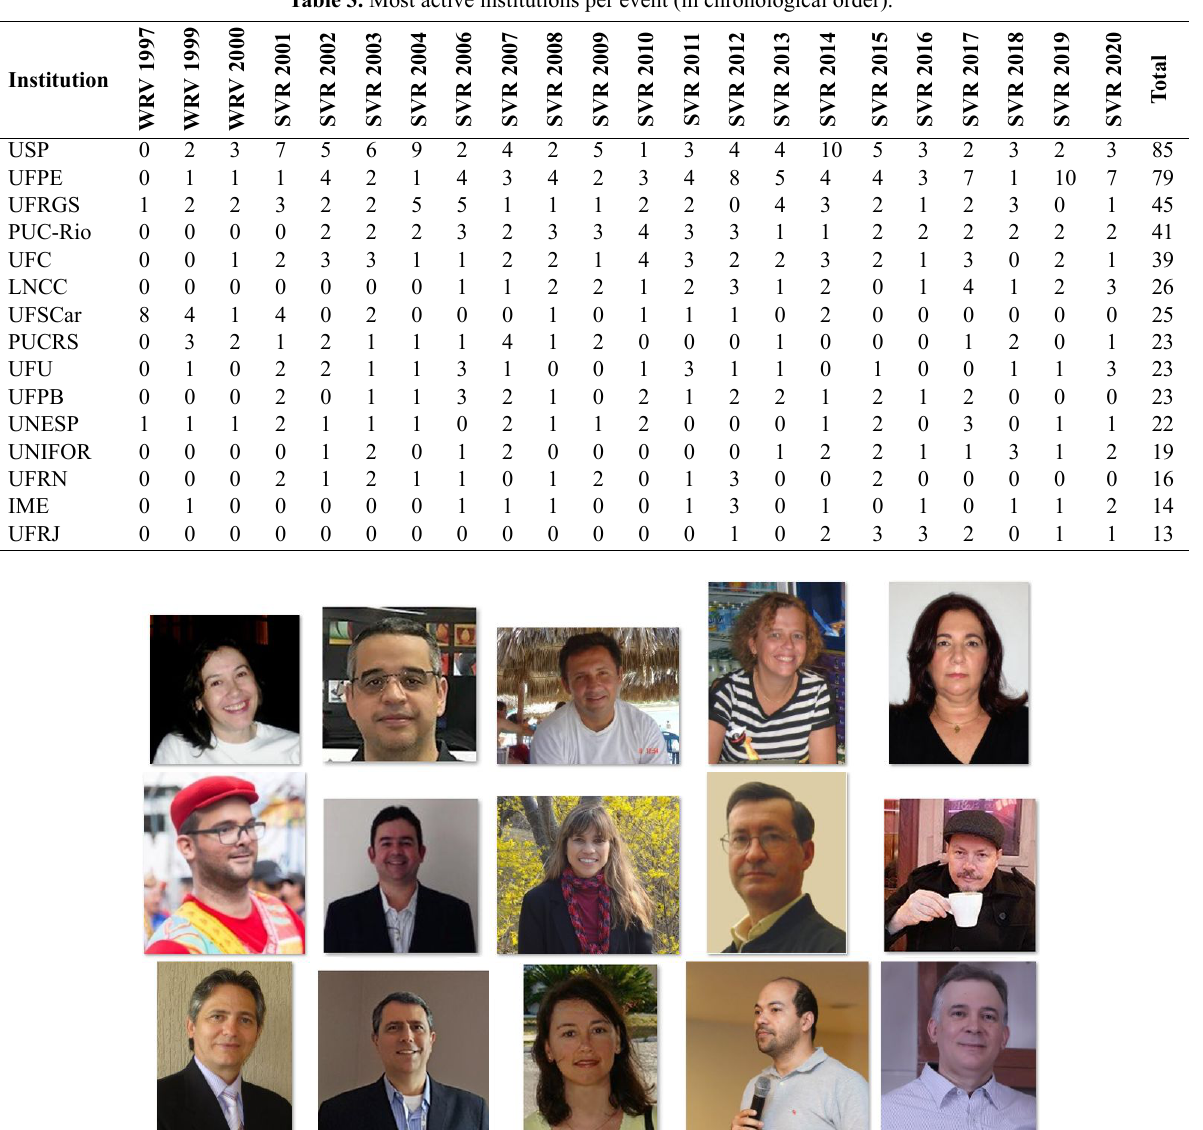
Table 3. Most active institutions per event (in chronological order).